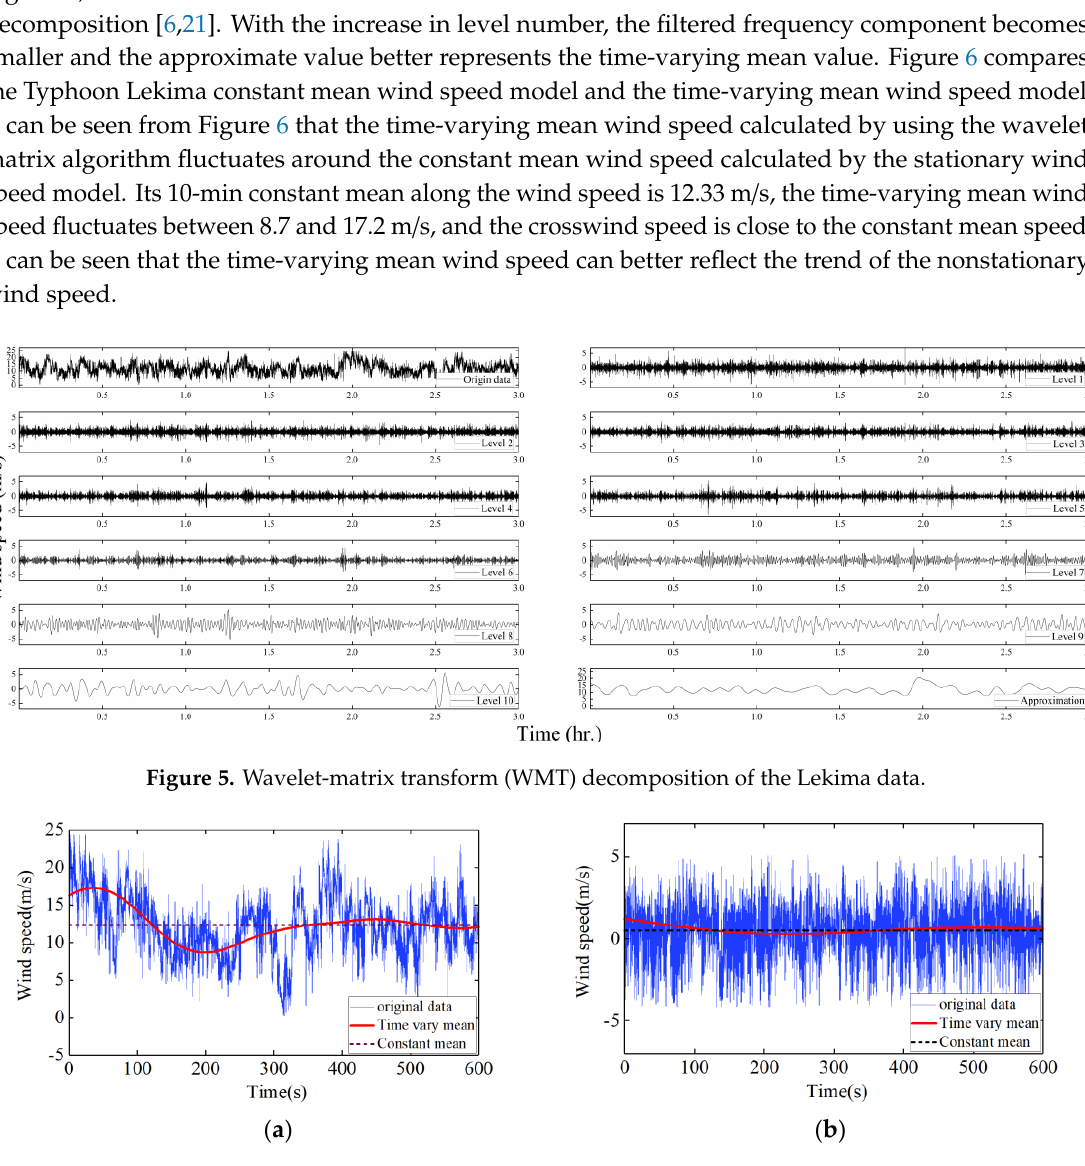
Figure 6. Comparison of the constant mean and time-varying mean wind speeds: ( a ) longitudinal component; ( b ) lateral component.